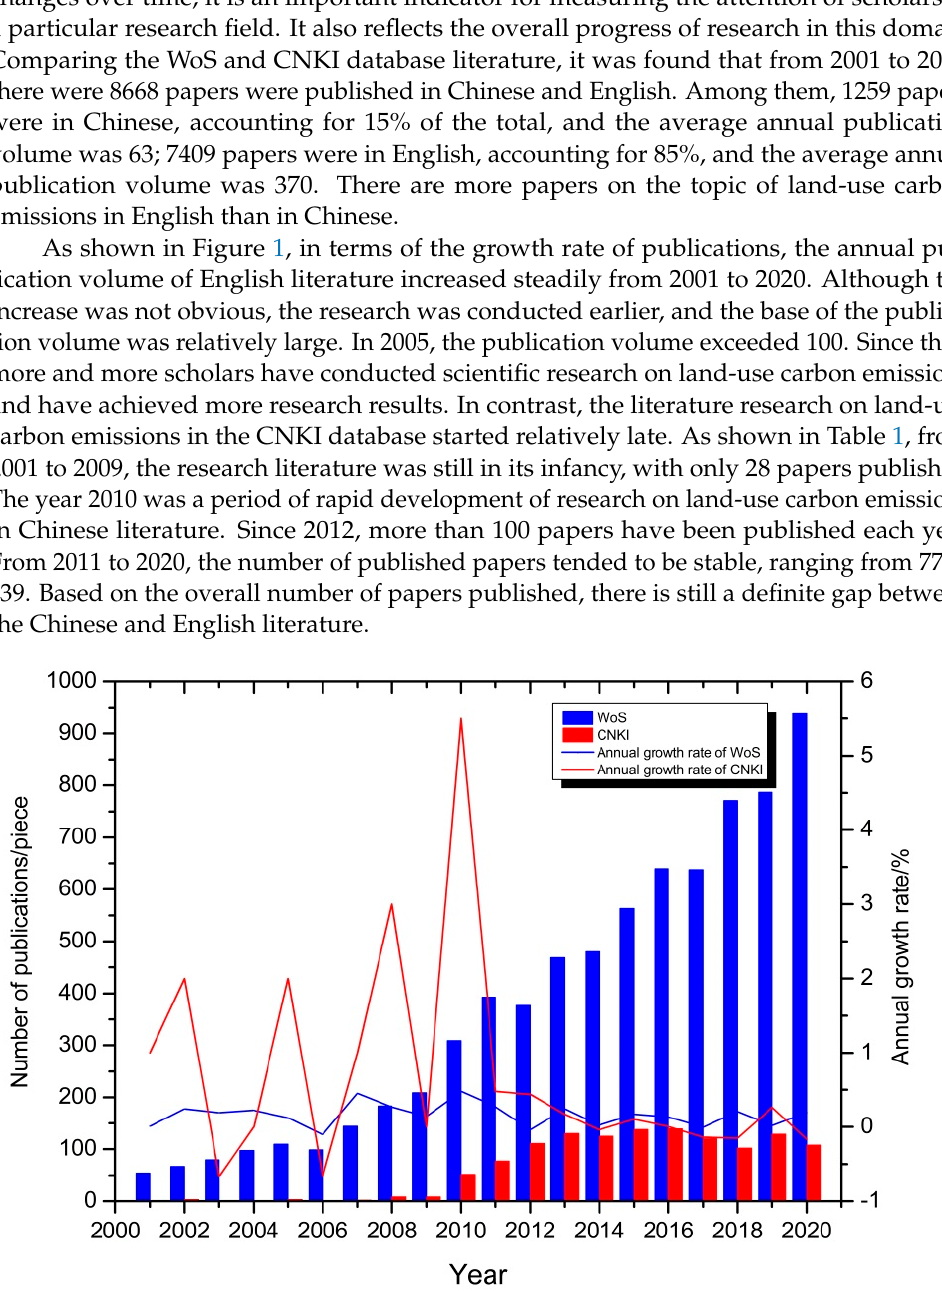
Figure 1. Annual publication volume and growth rate in 2001 − 2020.